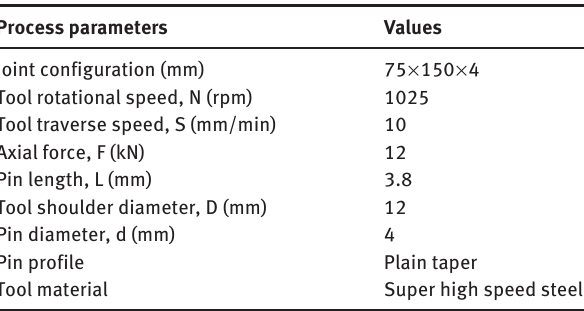
Table 1: FSW process parameters and tool dimensions used in this